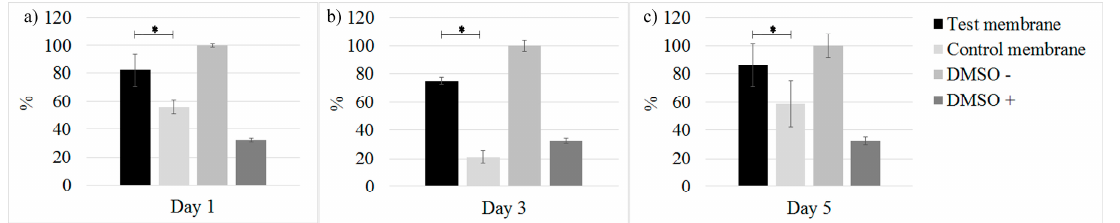
Figure 3. MTT assay. Vitality analysis comparison between both membranes at ( a ) 1; ( b ) 3 and ( c ) 5 days. * P < 0.001.